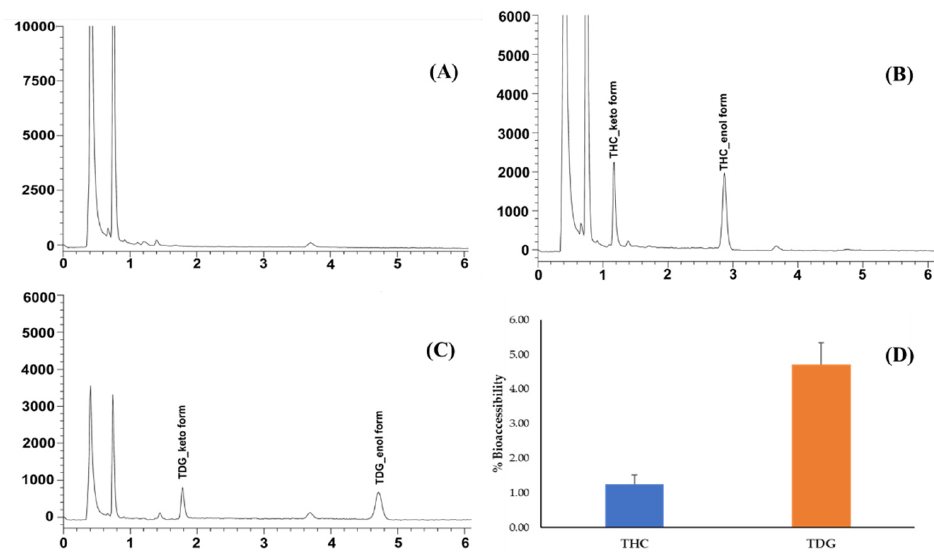
Figure 4. Representative chromatograms of ( A ) blank digestive enzyme, ( B ) THC and ( C ) TDG after digestion; ( D ) %Bioaccessibility of THC and TDG (mean ± SD, n = 3 ).